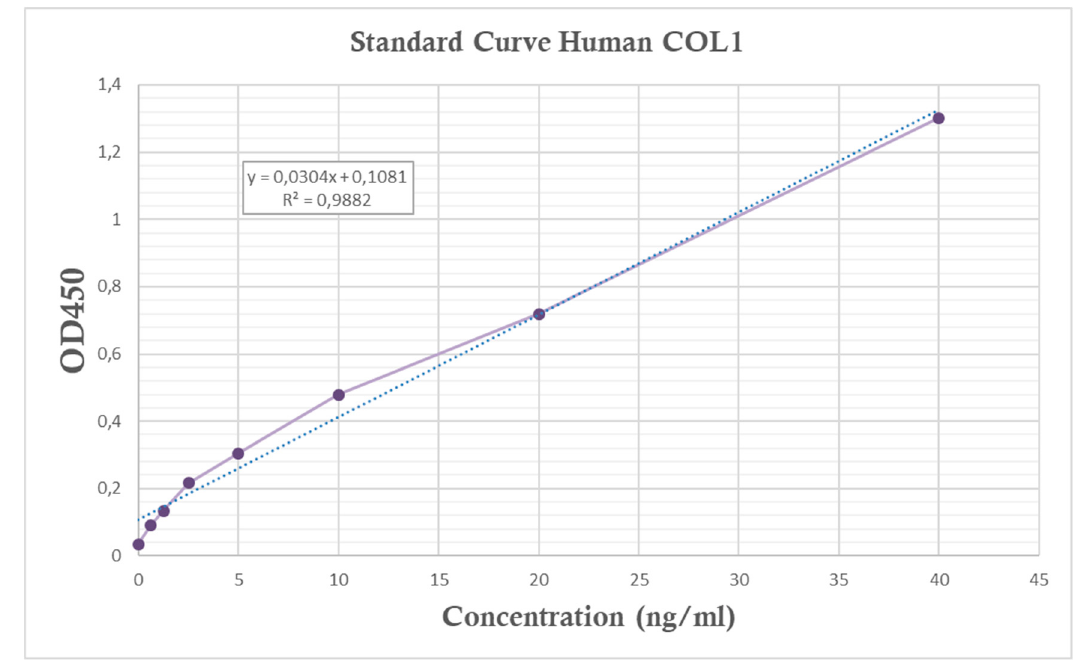
Figure 4. Standard curve used in ELISA assay. In the top-left box, the equation of the line used to obtain the concentrations of the samples is given, in addition to the correlation coefficient R 2 , which indicates a strong relation between the two variables (optical density (OD) and collagen type I (COL1) concentration) as it is close to 1.